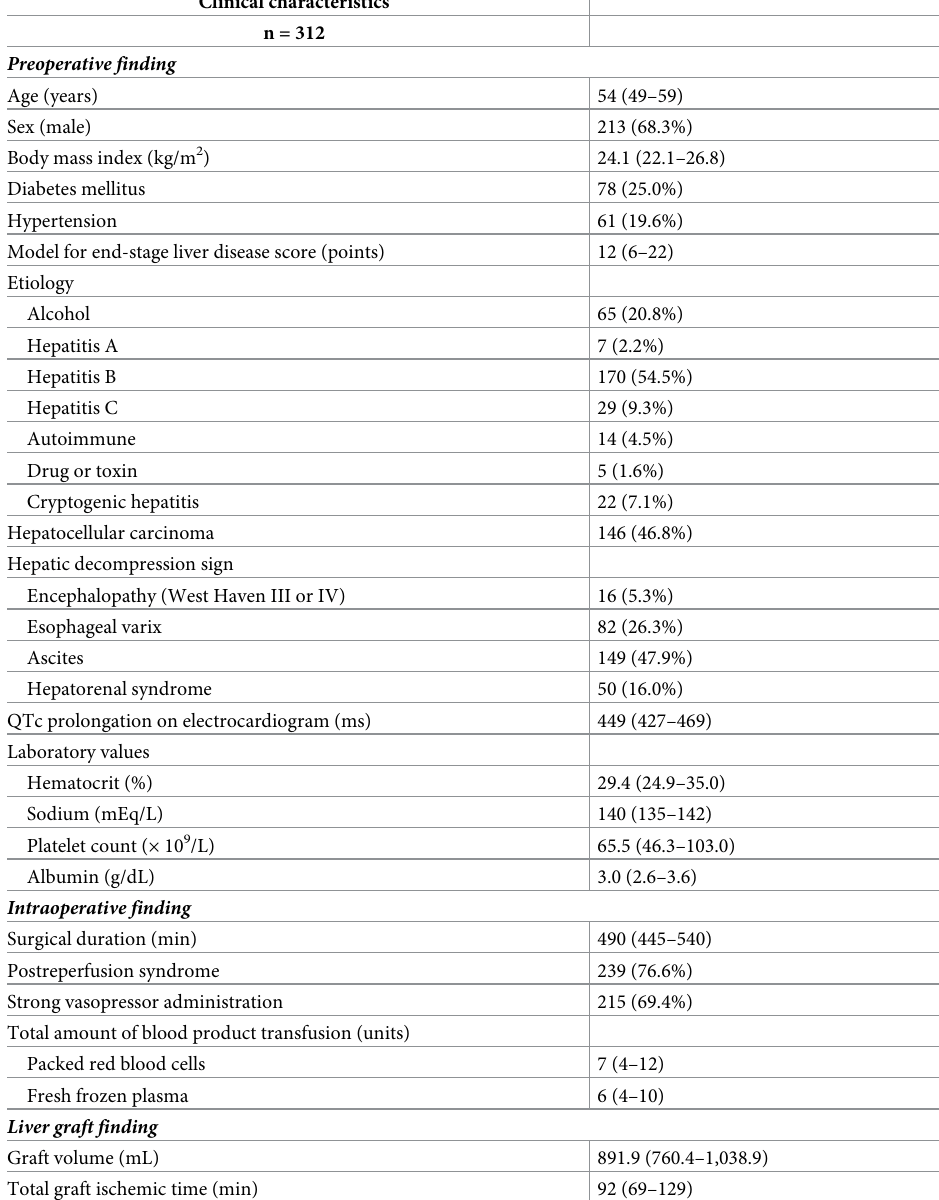
Table 1. Clinical characteristics of patients undergoing living-donor liver